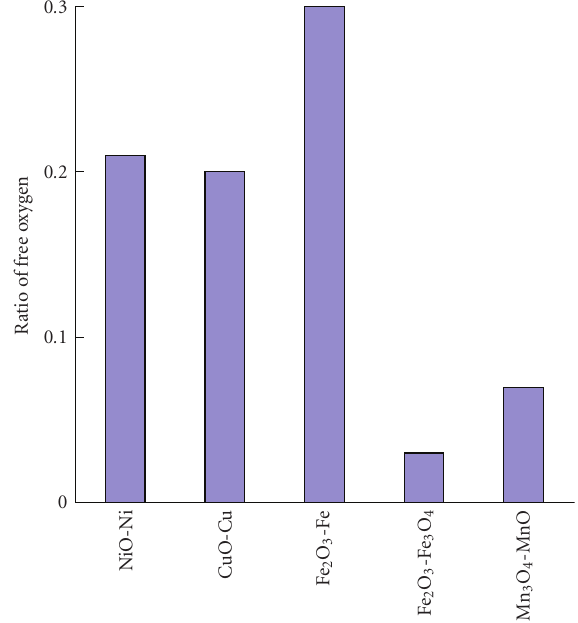
Figure 2: Mass ratio of active oxygen for di ff erent metal